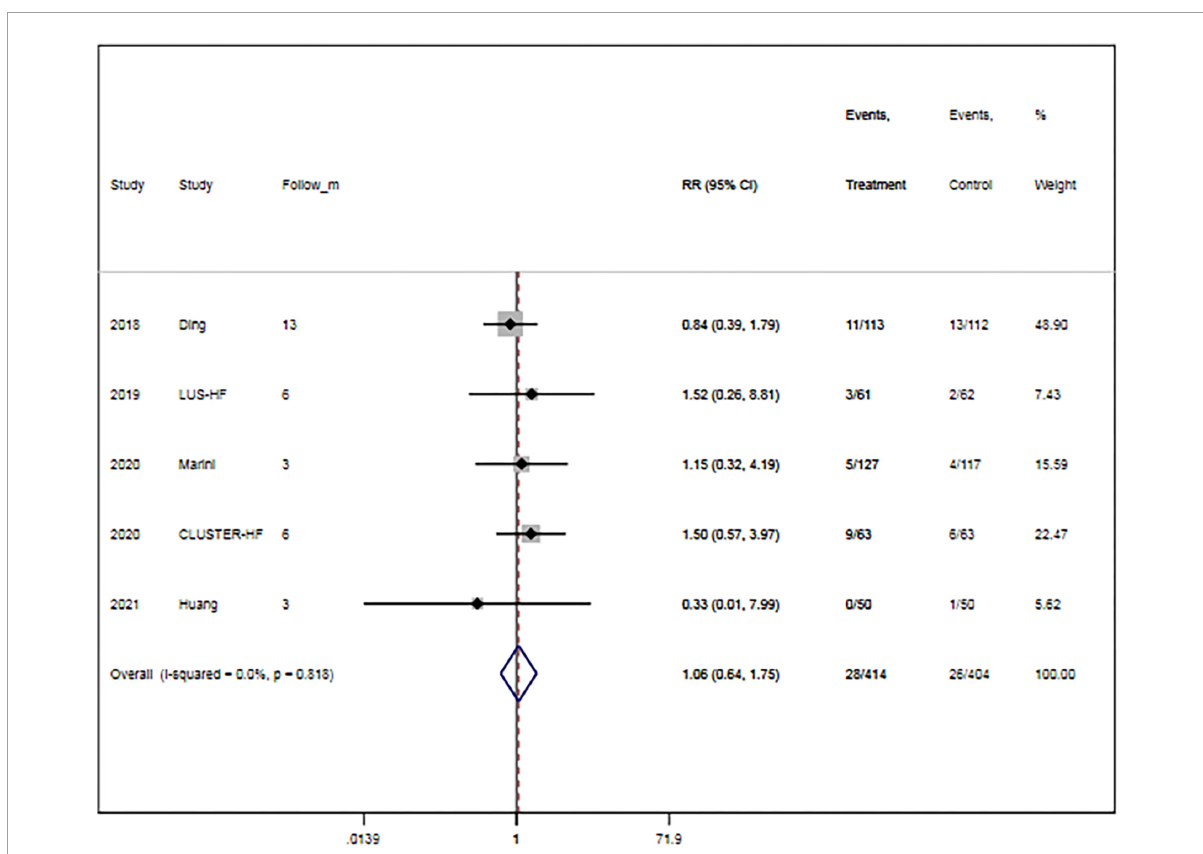
FIGURE3 Lung ultrasound-guided treatment is not associated with a decreased risk of mortality. Fixed-effects model ( I 2 = 0). LUS, lung ultrasound; RR, relative risk; CI, confidence interval.